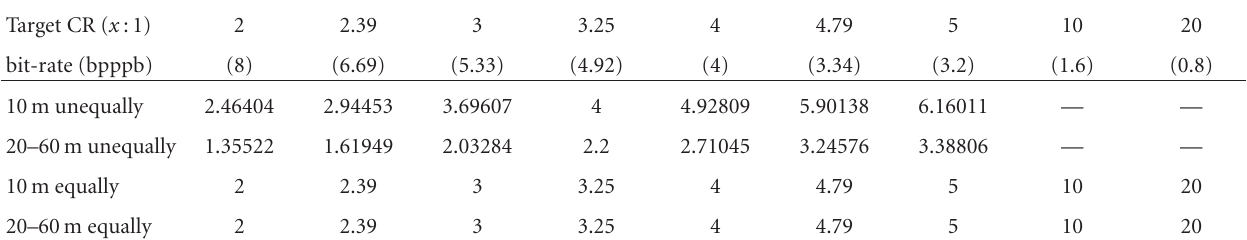
Table 1: Compression ratio (CR, expressed as x :1, e.g., 5: 1) and distribution among bands: two approaches were used. Moreover bit rates in bpppb are also indicated (compressed images inside the simulator have a bit-depth of